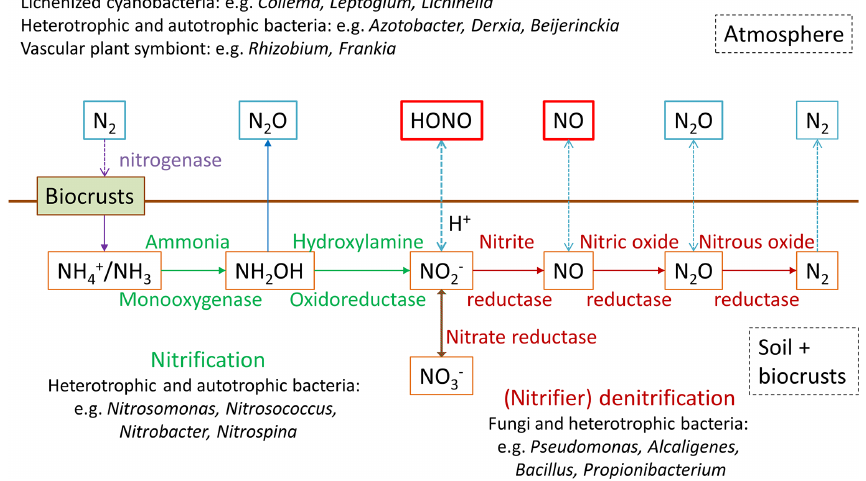
Figure 1. Nitrogen cycle at the atmosphere and pedosphere–biosphere interface including nitrogen fixation, nitrification, denitrification and emission. Enzymes and organisms involved are